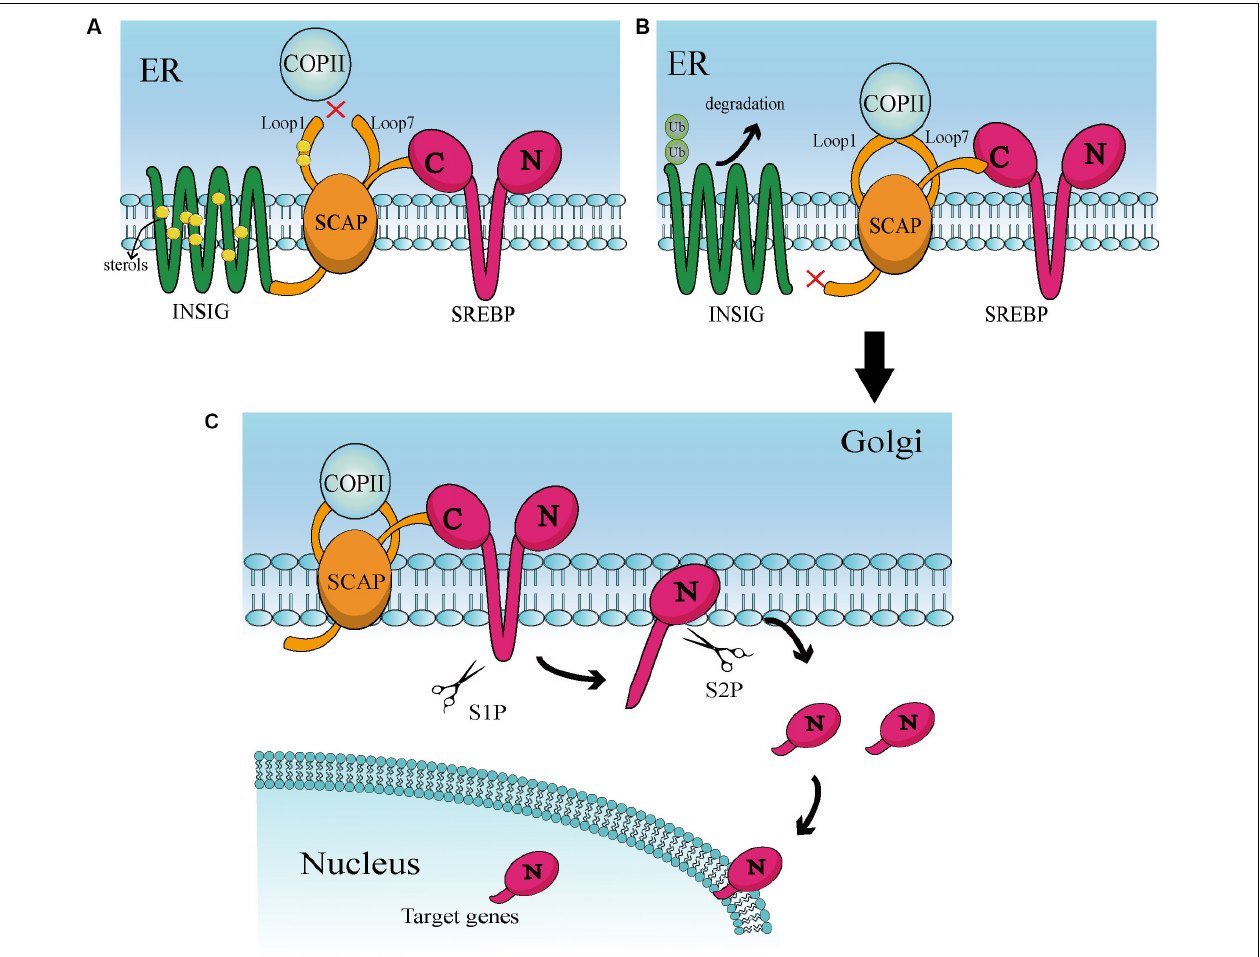
FIGURE 1 | (A) At high sterol levels, the sterol binds to Loop 1 and induces conformational changes in SCAP, thereby increasing its affinity for INSIG. Then, binding of SCAP and INSIG triggers a second conformational changes in SACP, leading to the dissociation of Loop1 and Loop7. This conformation prevents COPII from binding to SCAP. In addition, sterol is combined with INSIG to keep the stability of INSIG. These interactions help the INSIG/SCAP/SREBP complex to be preserved on the ER membrane. (B) In a sterol-deprived environment, the reduction of sterol leads to ubiquitination and rapid degradation of INSIG. This gives the SCAP/SREBP complex an opportunity to escape ER. Deprivation of sterols also triggers conformational changes that enable Loop1 to bind to Loop7, which allows SCAP to bind to COPII. Then, COPII transports the complex to the Golgi apparatus via vesicles. (C) When in the Golgi, SREBP will be continuously cleaved by